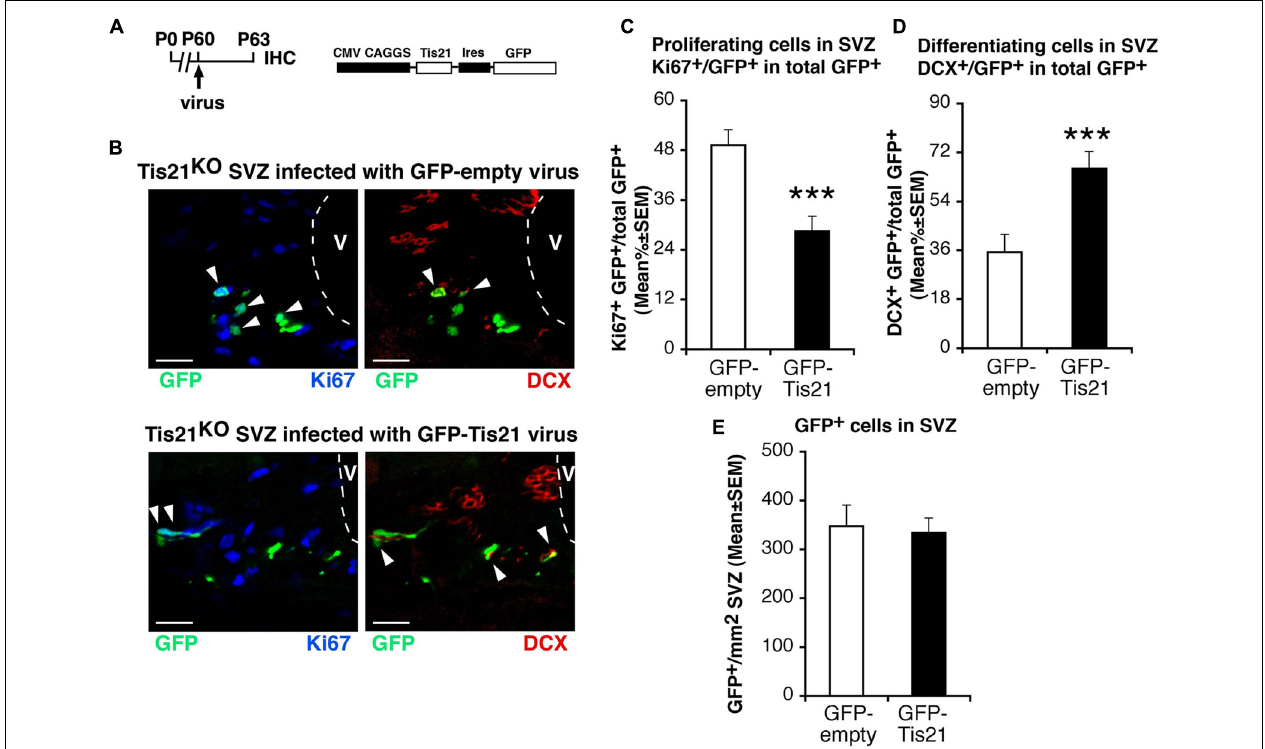
FIGURE 3 | Tis21 -retrovirus rescues the uninhibited proliferation and the defective differentiation of Tis21 -null SVZ stem cells and neuroblasts. (A) Scheme of retrovirus infection and analysis, and structure. (B) Representative confocal images of coronal sections in the dorsal SVZ region, double labeled with GFP (after infection with either GFP- Tis21 or GFP-empty retroviruses for 72 h) and with Ki67 or DCX. The ventricle (V) is outlined by dashed lines. Scale bars, 25 μ m. (C) Percentage ratio between Ki67 + /GFP + or (D) DCX + /GFP + cells and the total number of infected